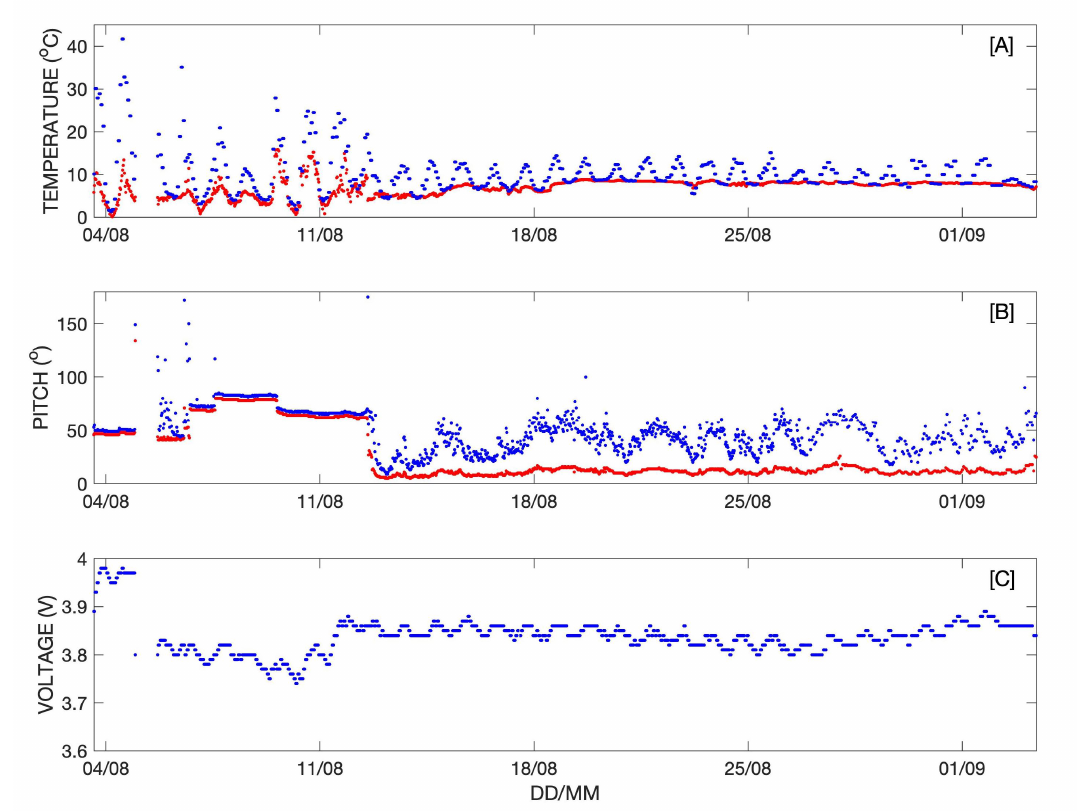
Figure 11. ( A ) External and internal temperature are indicated by red and blue dots, respectively. ( B ) Average and maximum pitch are indicated by red and blue dots, respectively. ( C ) Battery